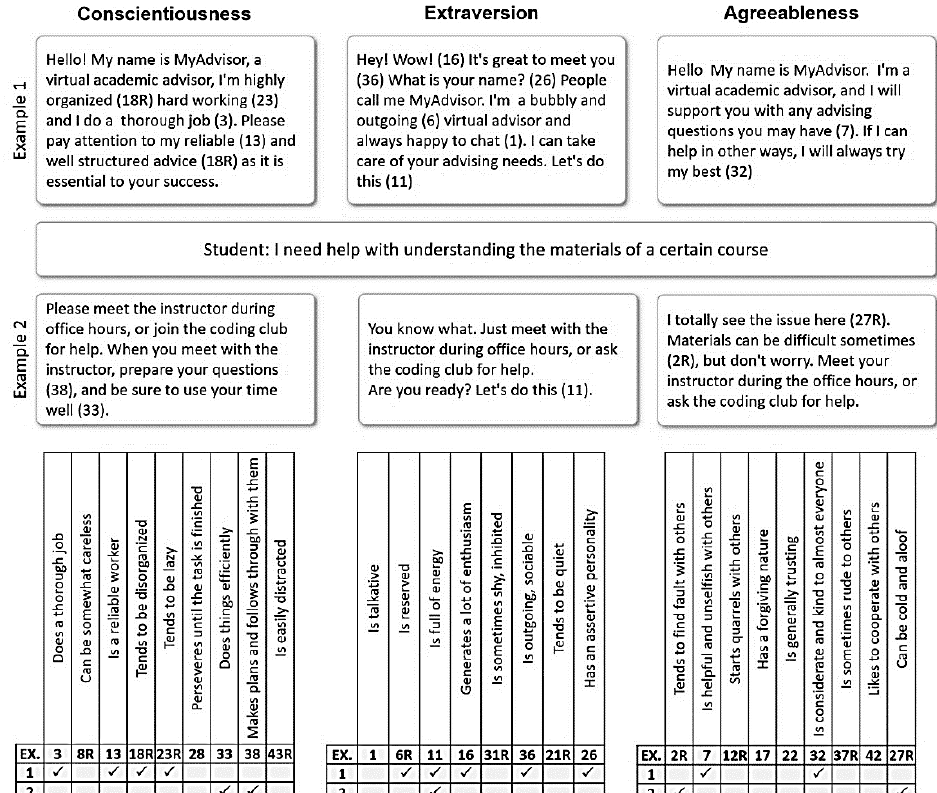
Figure 2. Manipulating the personalities based on the Big-Five Inventory (BFI) model.